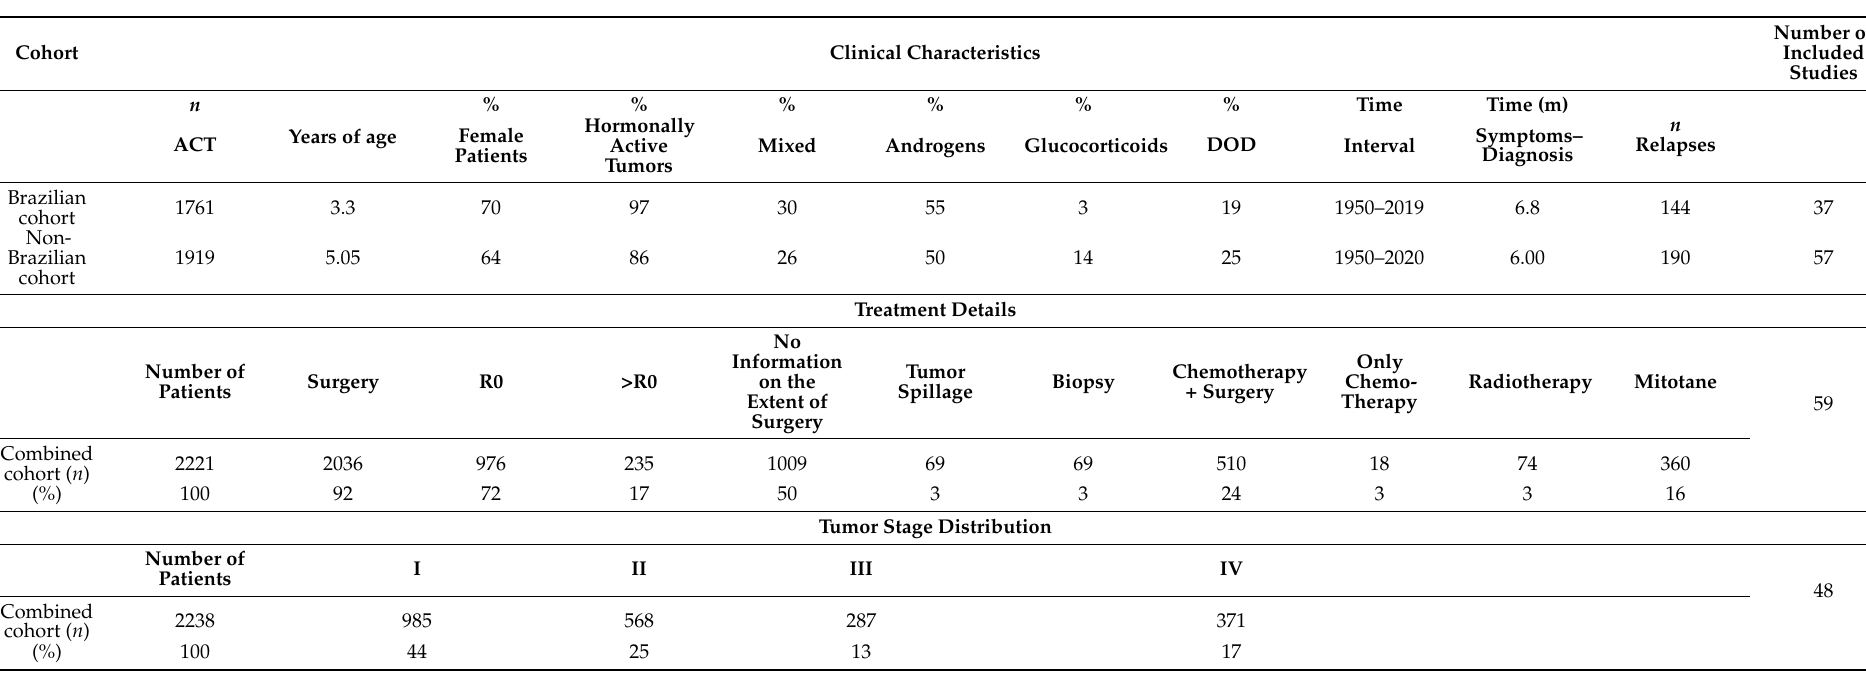
Table 2. Summary of the data of the pediatric patients with an adrenocortical tumor from the selected original publications identified by systematic literature review regarding clinical characteristics, treatment details, and tumor stage